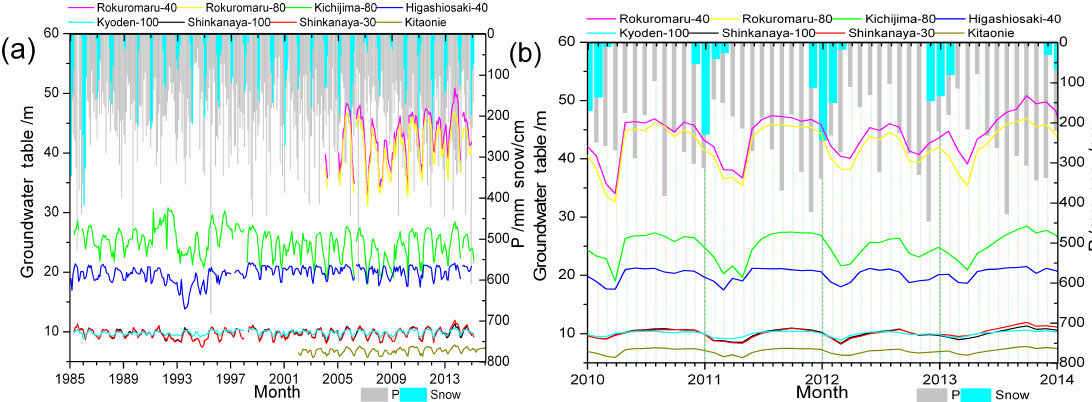
Figure 2. Monthly groundwater table, rainfall, and snowfall from 1985 to 2014 (a) , and from 2010 to 2014 (b) . Table 2. Description and prediction of rainfall, snow, and the water